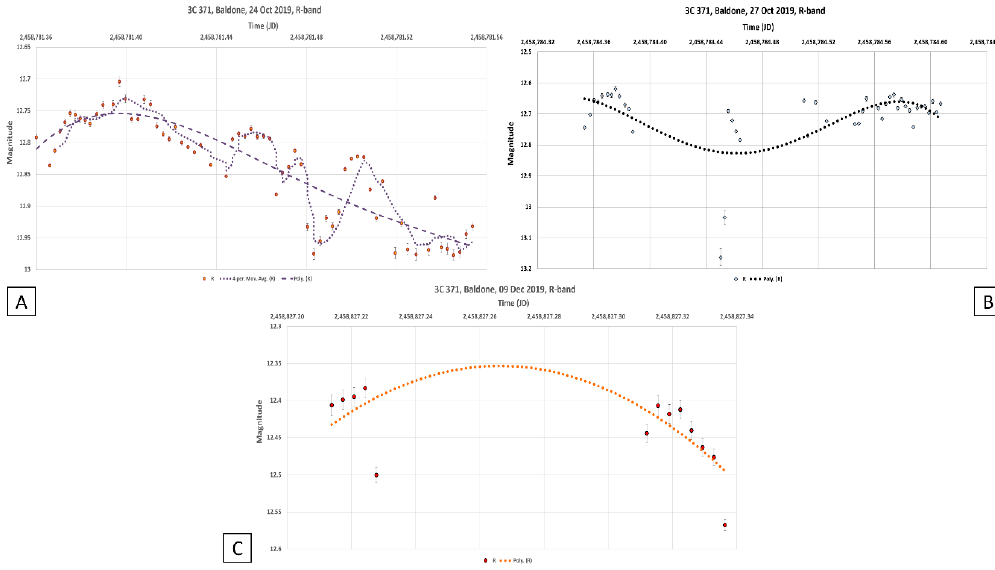
Figure 10. Light curves for three nights (24 ( A ), 27 ( B ) October and 9 December ( C ) 2019) obtained at the Baldone Observatory. The polynomial trends are plotted in the data, showing the brightness variations of 3C 371 during these individual nights of observations.